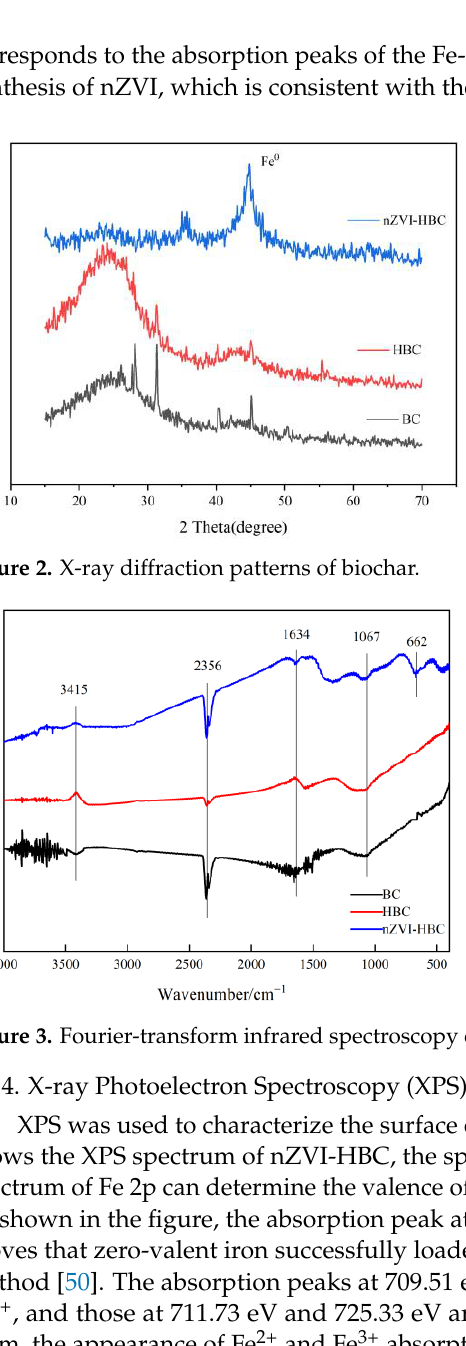
Figure 2. X-ray diffraction patterns of biochar.